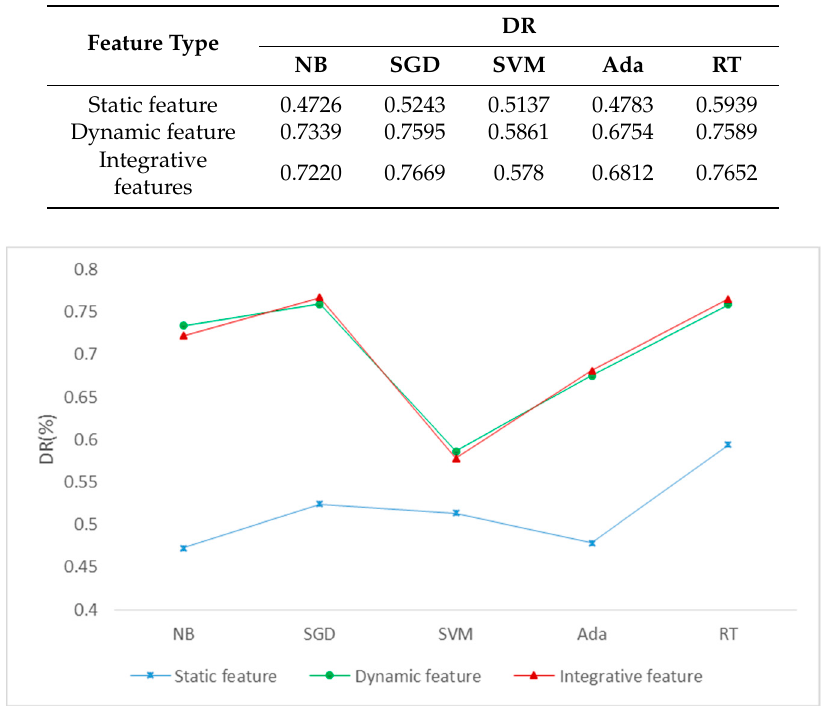
Figure 7. The obfuscated-detection results. DR (Detection Rate, DR), NB (Naive Bayes, NB), SGD (Stochastic Gradient Descent, SGD), SVM (Support Vector Machine, SVM), Ada (Adaboost, Ada) and RT (Random Trees, RT).